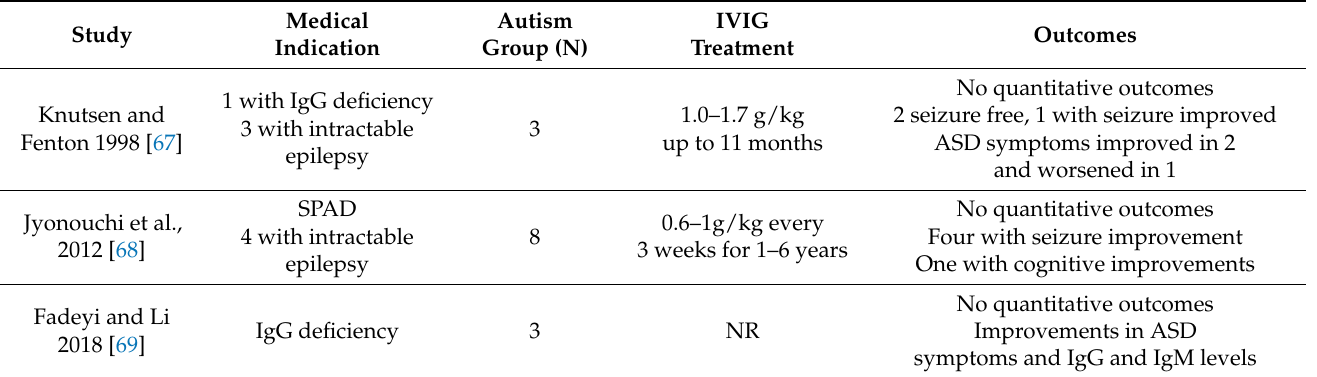
Table 6. Retrospective Uncontrolled Case Series. Specific Polysaccharide Antibody Deficiency (SPAD); Aberrant Behavior Checklist